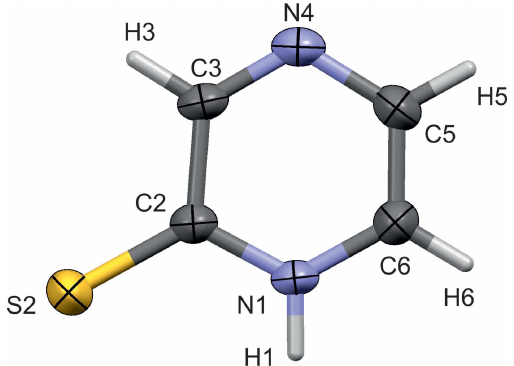
Figure 4 The molecular Hirshfeld surfaces of pyrazine-2(1 H )-thione mapped with d norm . Red areas represent intermolecular contacts of distances shorter than the van der Waals separation.